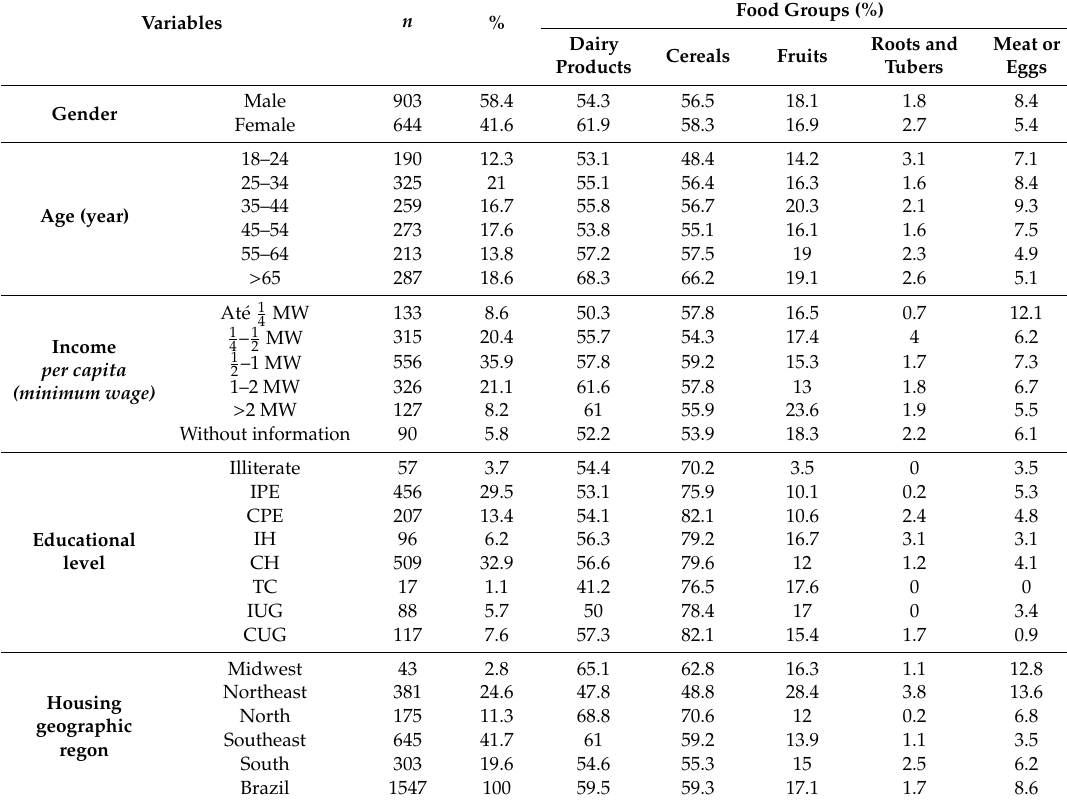
Table 3. Distribution of breakfast food groups by gender, age group, per capita income, educational level, and geographic housing region of the research participants.